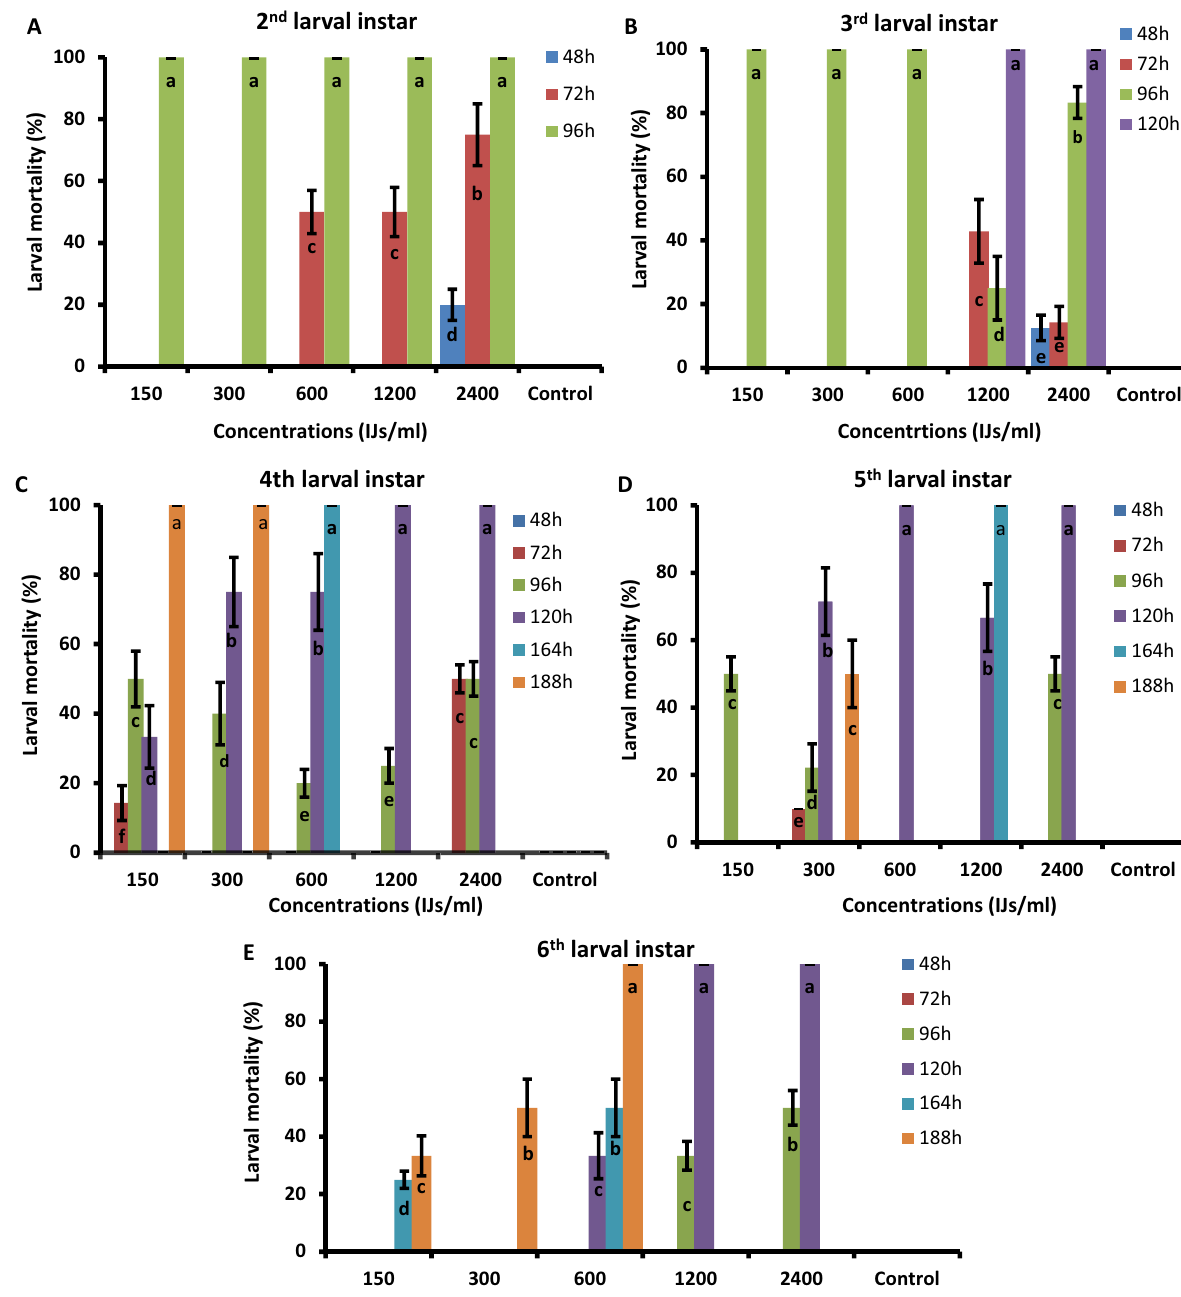
Fig. 3 Mortality percentages of different larval instars of Spodoptera frugiperda exposed to different infective juveniles nematode concentration (IJs/ ml) of Heterorhabditis indica . Columns shared with the same letters within the same instar are statistically insignificant ( P >